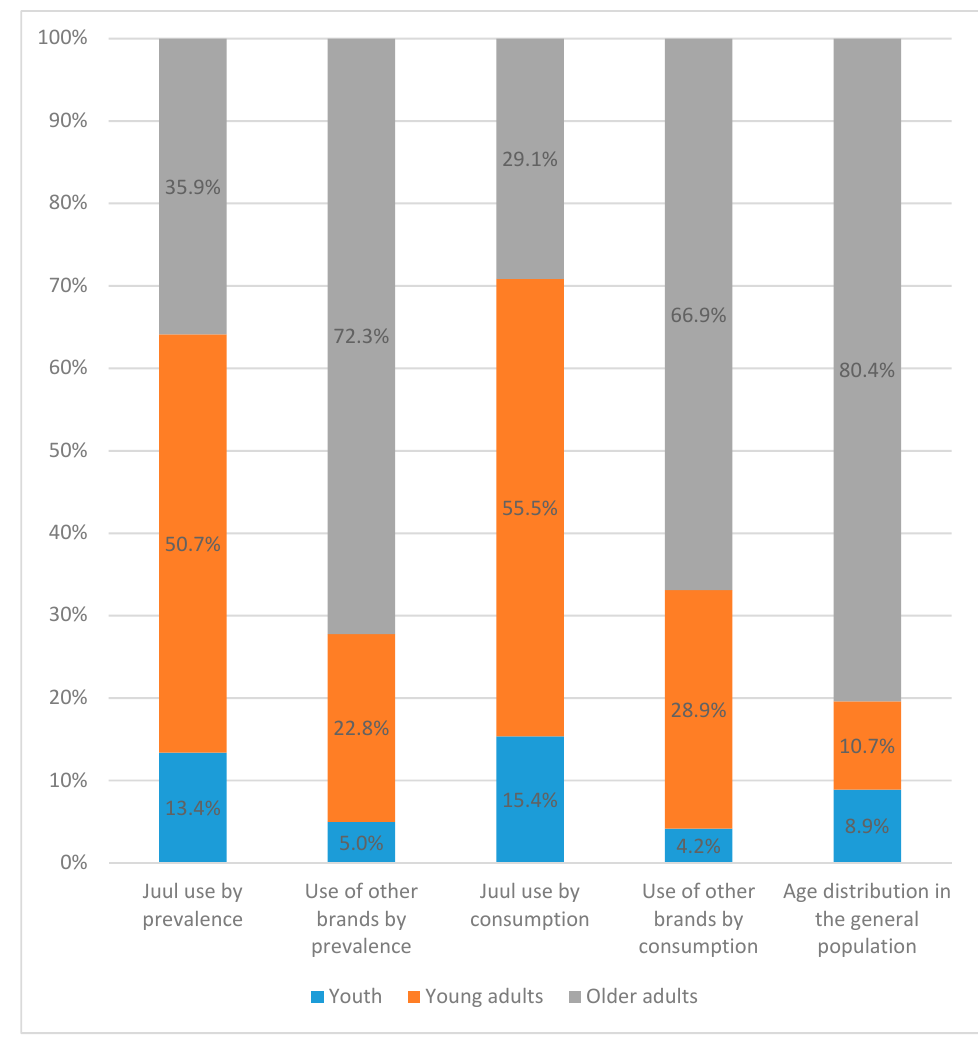
Figure 1. Distribution of JUUL use vs. use of other e-cigarette brands among U.S. youth, young adult, and adult e-cigarette users, compared with the proportion of population size.